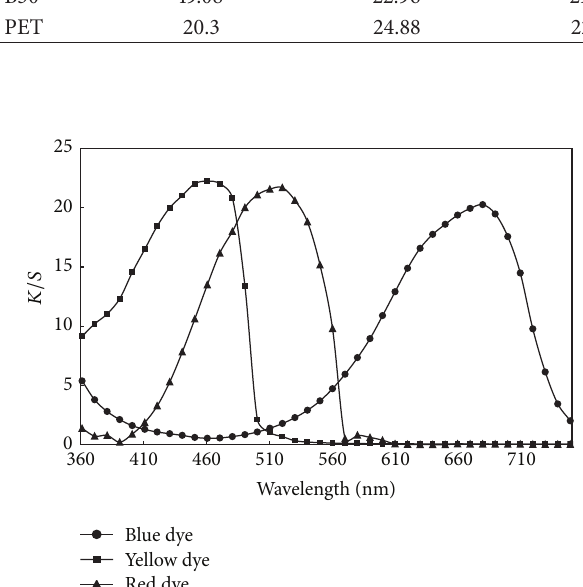
Figure 5: K/S curves of pure PET fiber dyed with three disperse dyestuffs at boiling ( ≈ 100 ∘